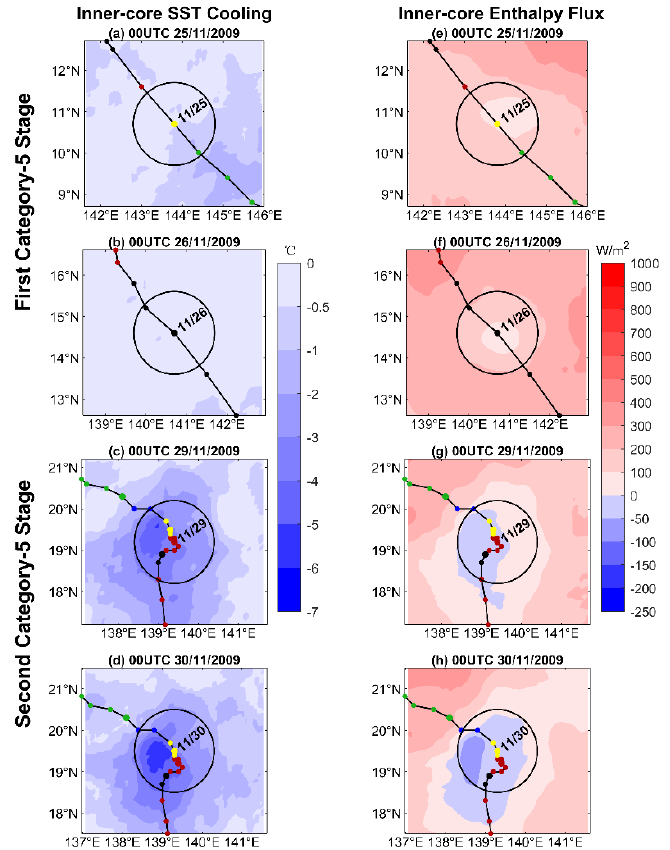
Figure 8. Evolution of the inner-core SST cooling (shaded, °C) and inner-core enthalpy flux (shaded, W m −2 ) in the SL stage and ST stage. The black solid circle represents the radius of 100 km from the typhoon, indicating its inner core.